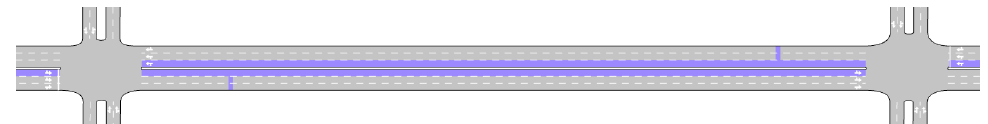
Figure 8. The 2-Intersection model, which represents an interrupted urban setting with a detector spanning one whole lane (purple).